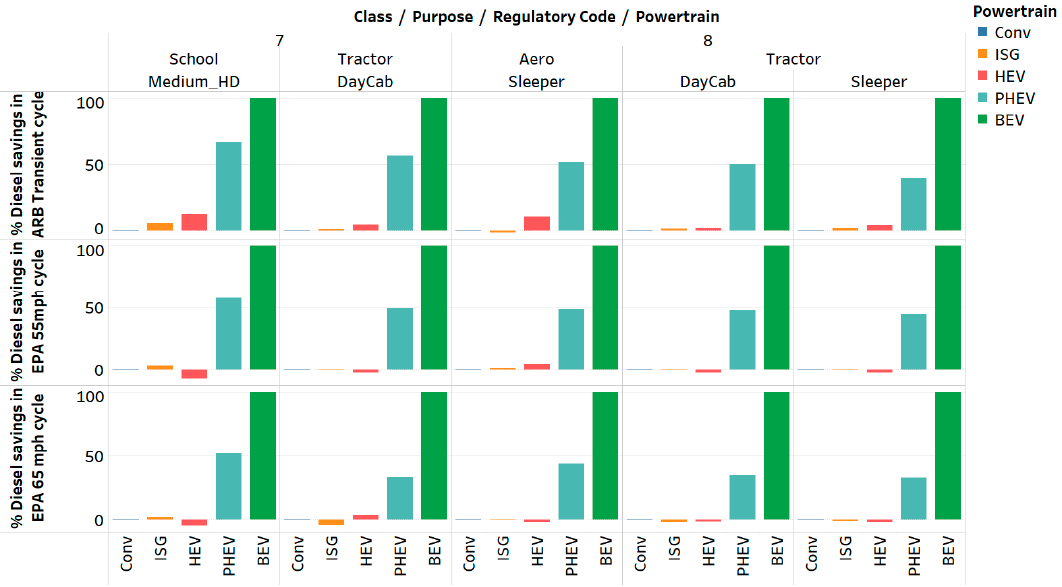
Figure 8. Fuel savings in heavy-duty trucks.